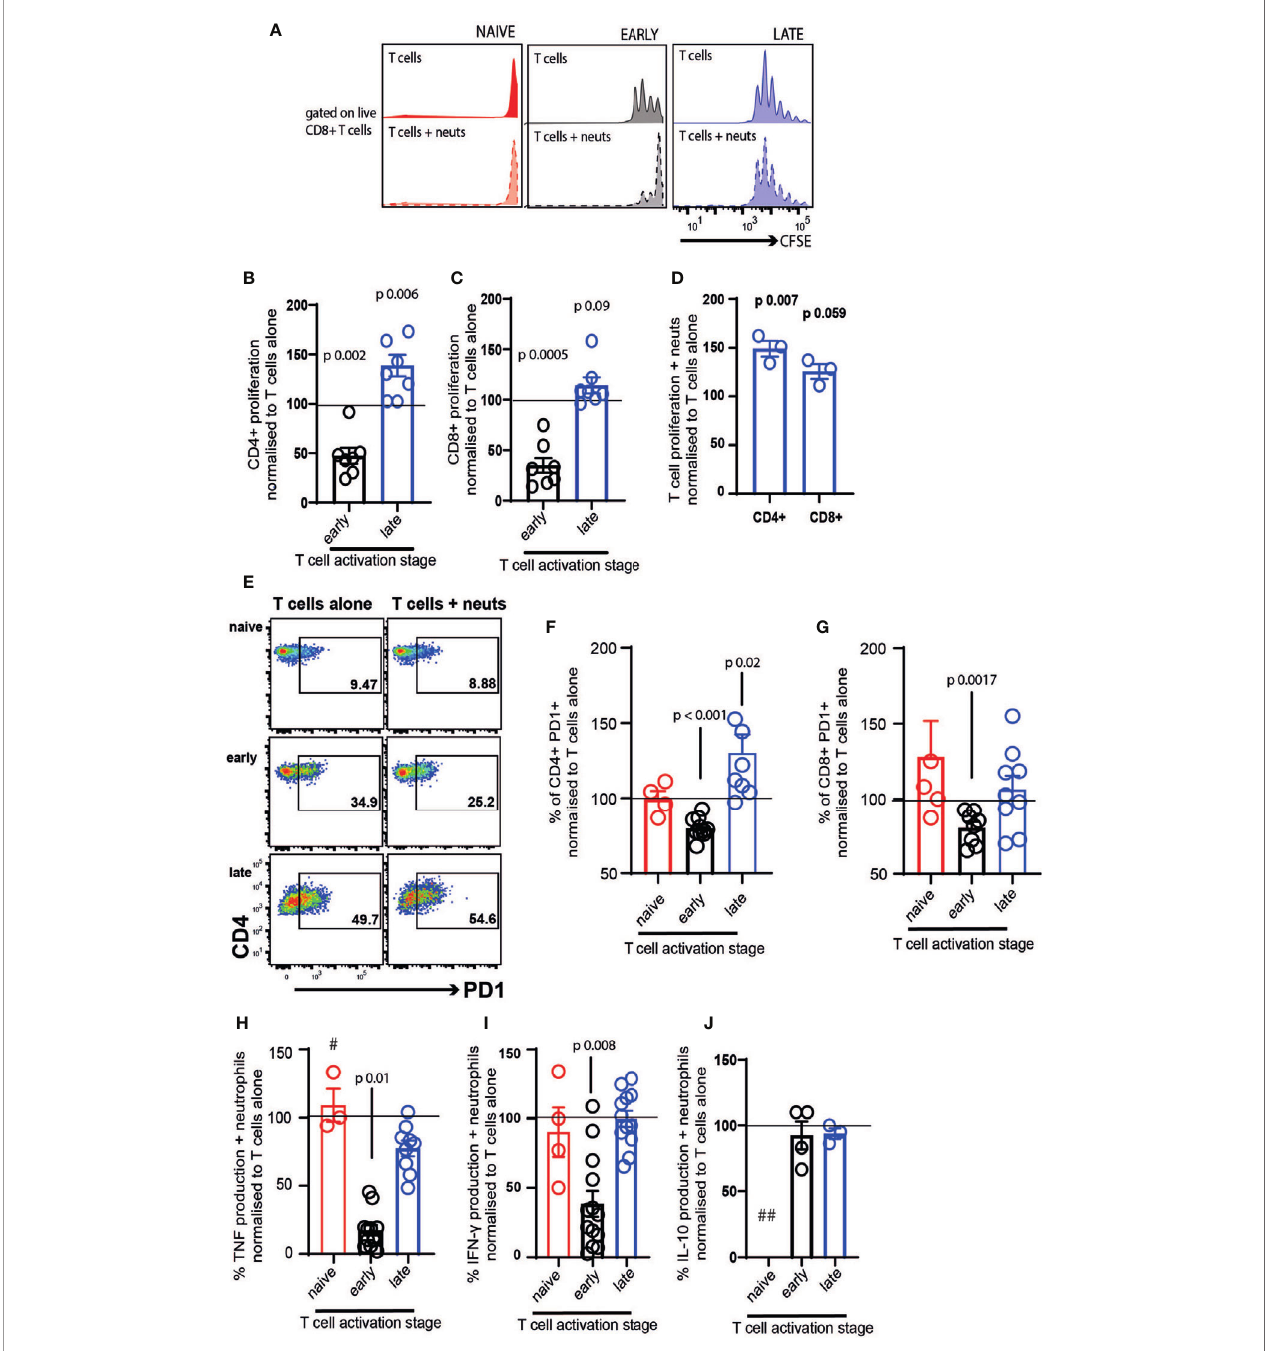
FIGURE 2 | Neutrophil contact differentially affects early- and late-stage activating T cells. T cells and neutrophils were isolated from peripheral blood of healthy human donors using negative magnetic separation, and were cultured together at a 5:1 neutrophil: T cell ratio. (A) representative fl ow cytometry plot and (B – D) quanti fi cation of proliferation of CD4+ and CD8+ T cells alone and in the presence of resting neutrophils. (E – G) Following 24 hours co-culture T cell activation was assessed by fl ow cytometry analysis of PD-1 and (H – J) cell culture supernatant was collected at 24 hours and cytokine production assessed by ELISA. In all cases red symbols = naïve T cells, black = early-activating and blue = late activating. # = two samples were below the limit of detection; ## = all samples were below the limit of detection. N values of individual donors, each of which was plated separately: (B, C) 7; (D) 3; (F, G) naïve 4, early 10 for CD4 and 7 for CD8, late 7 for CD4 and 8 for CD8 (H) naïve 3, early 13, late 10; (I) naïve 4, early 13, late 12; (J) early 4 late 3. Data between T cells exposed to neutrophils and control T cells were analyzed by paired t tests on raw data before conversion to